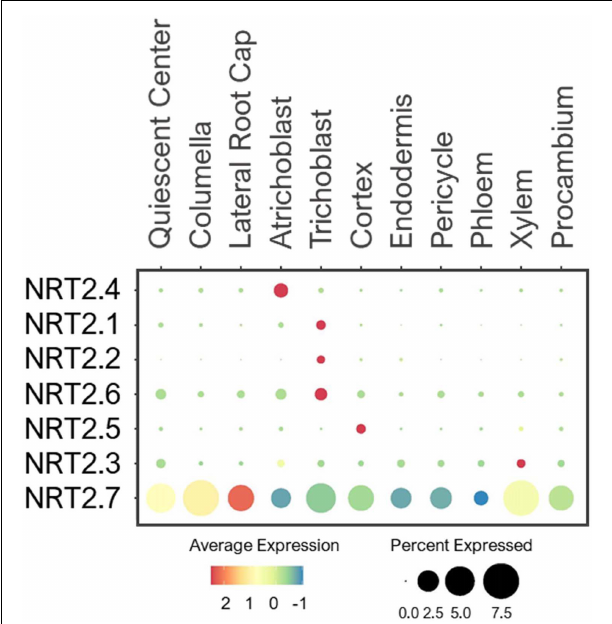
FIGURE 3 | Expression of the high-affinity NRT transporters in Arabidopsis root single cells. In dot plot, the circle size represents the proportion (%) of cells expressing a given gene, and the color of scale bar represents the mean expression (natural log +1 pseudocount).